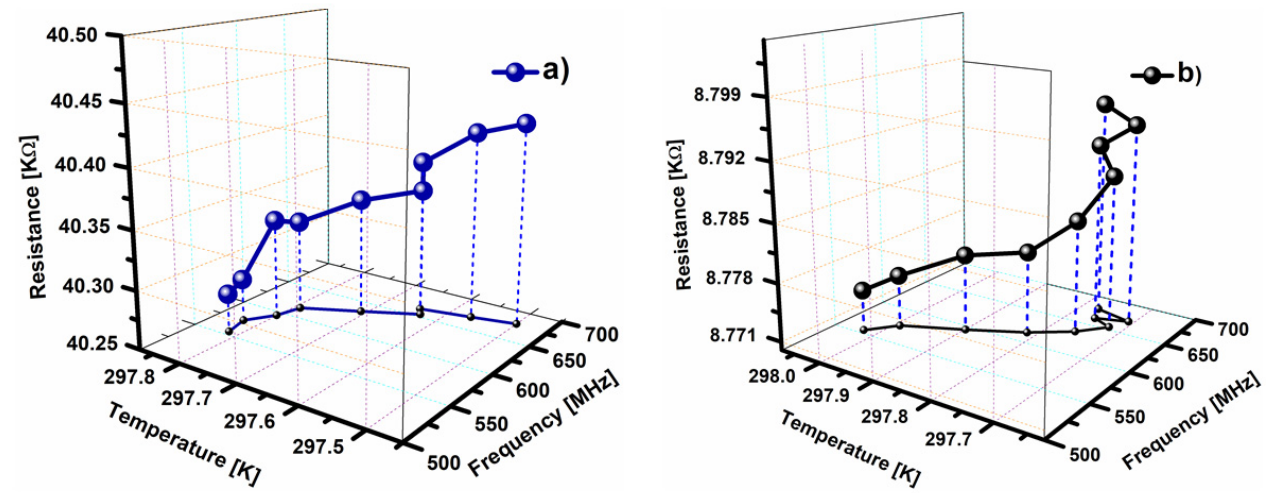
Figure 5. Temperature and resistance of SWCNT as a function of the incident radiation frequency: ( a ) uncracked film and ( b ) cracked film. Both films used as a bolometers coupled to a wideband planar fractal antenna.